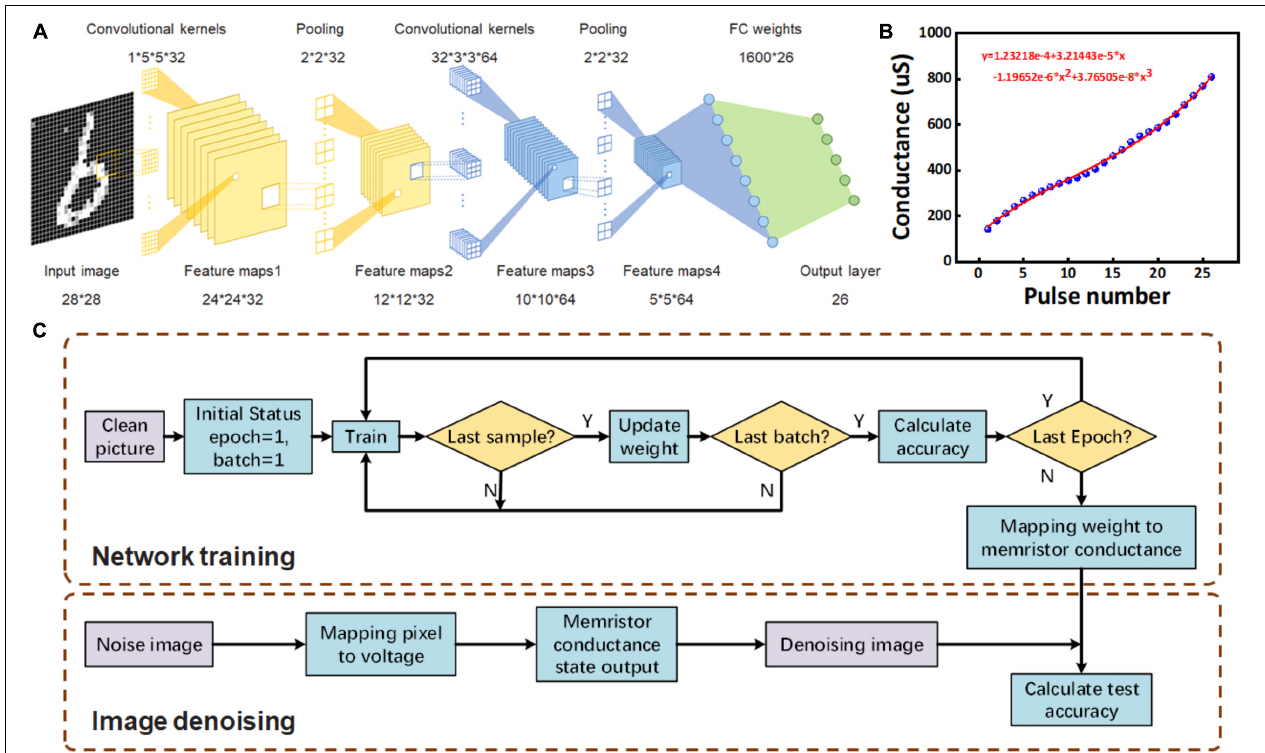
FIGURE 4 | (A) CNN architecture for 26 handwritten letter recognition. (B) The function curve fitted with 26 conductance states regulated by pulse. (C) Schematic flowchart for the simulation of supervised learning with CNN for image denoising and recognition.